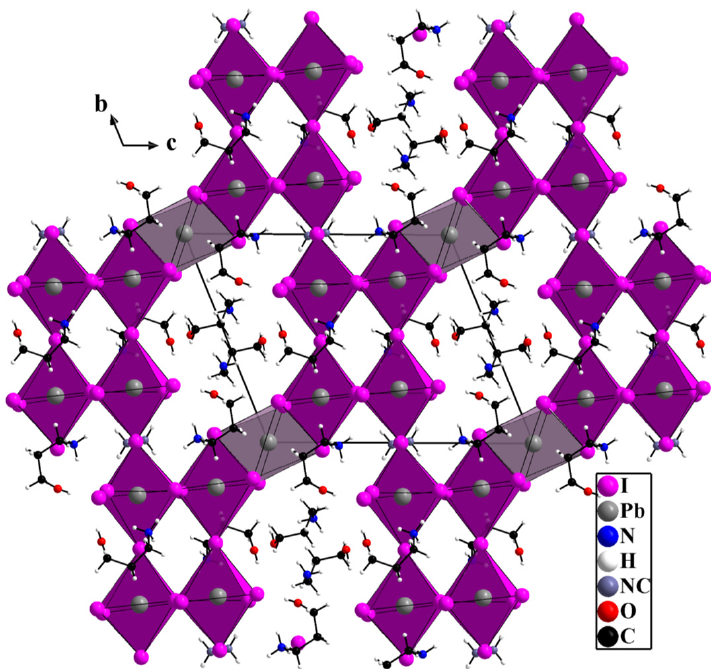
Figure 1. General view of the structure of (HPA) 6 (MA)Pb 5 I 17 showing the 3D lead iodide network resulting from 2D perovskite subnetwork (purple octahedra) linked together by PbI 6 face-sharing octahedra (grey octahedra).